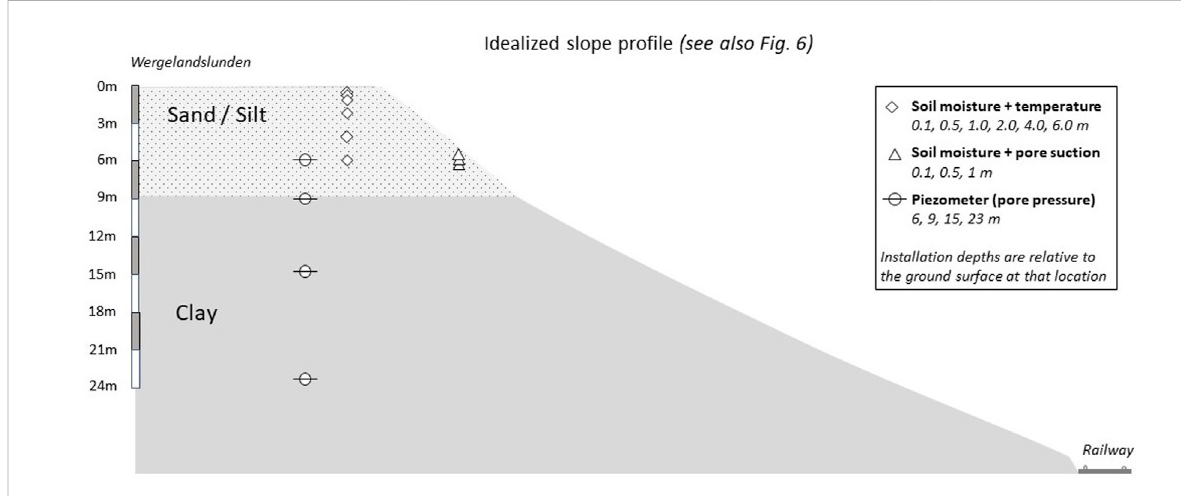
Schematic cross section of the studied slope (Figure 6) and depth location of the